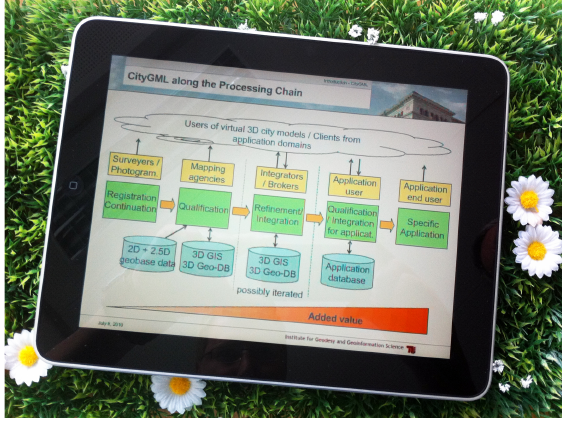
Figure 9: iPad with CityGML